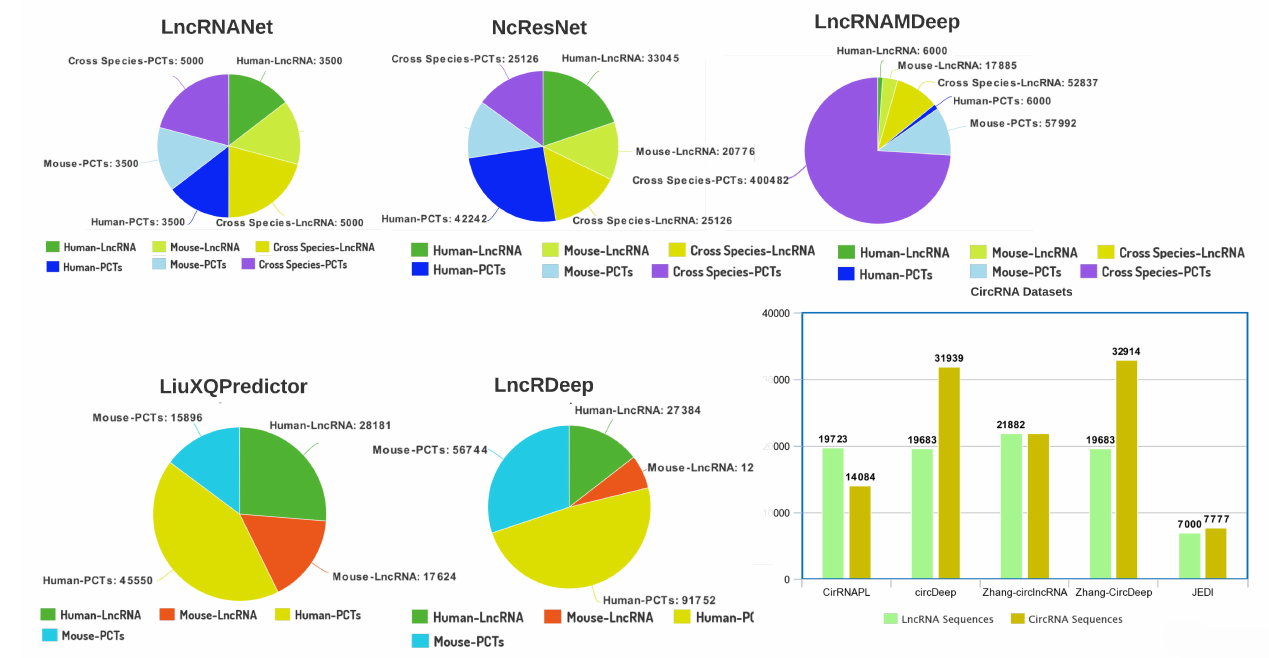
Figure 2. Statistics of different benchmark datasets used in the literature to evaluate the performance of ncRNA classifica- tion